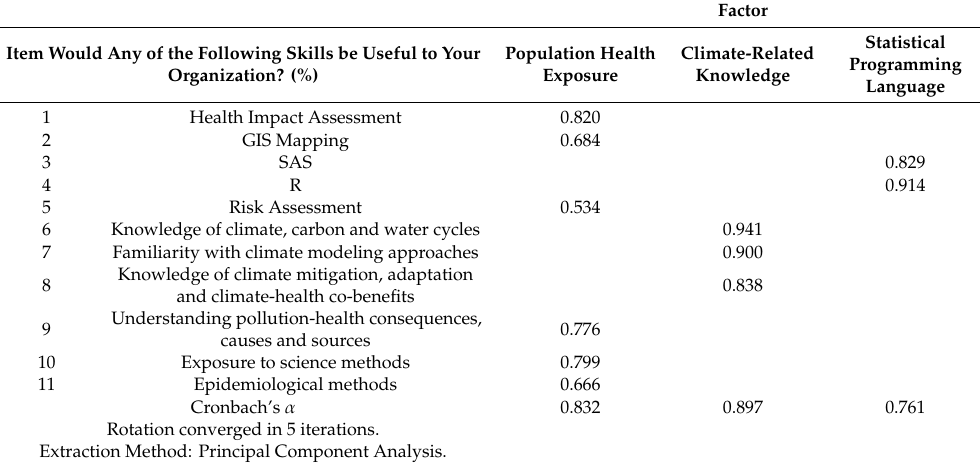
Table 5. Pattern matrix of the EFA solution (three factors, 13 items).